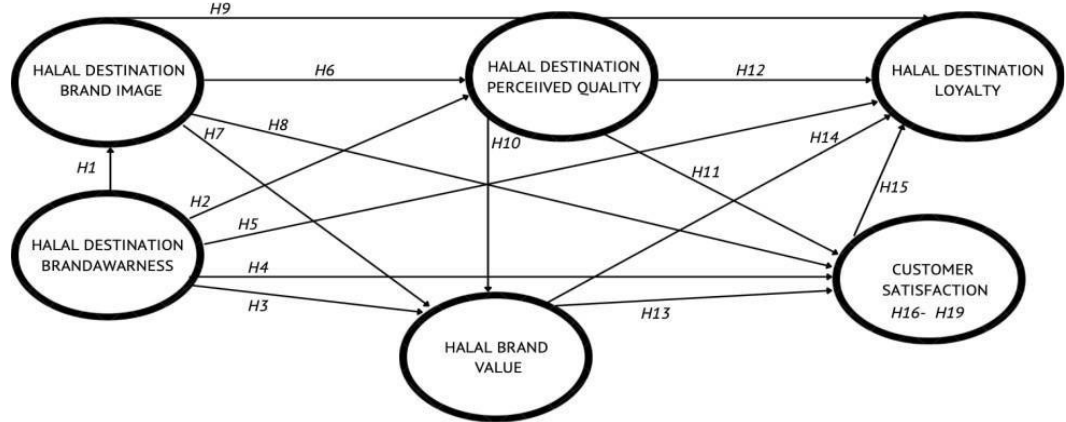
Figure 1. Research